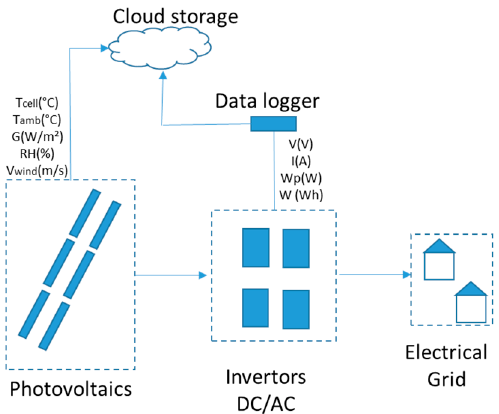
Figure 3. Schematic of the experimental outputs. Table 3. Measuring instruments details.